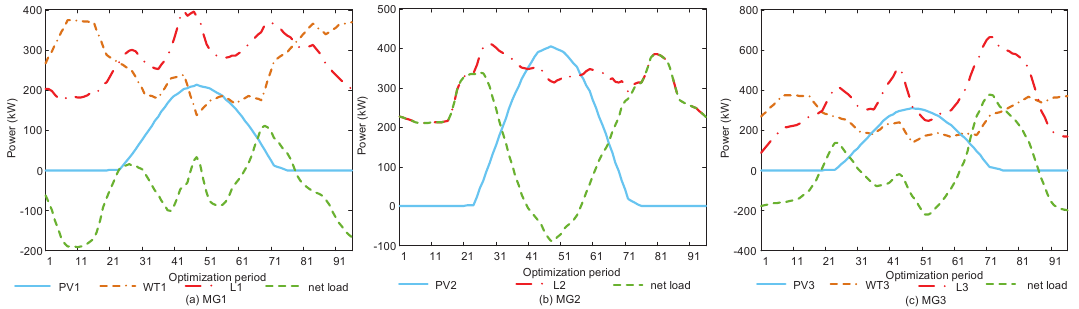
Figure 5. Net power curve of each MG and total net power curve of the coalition on Day 1 of Scenario 1.